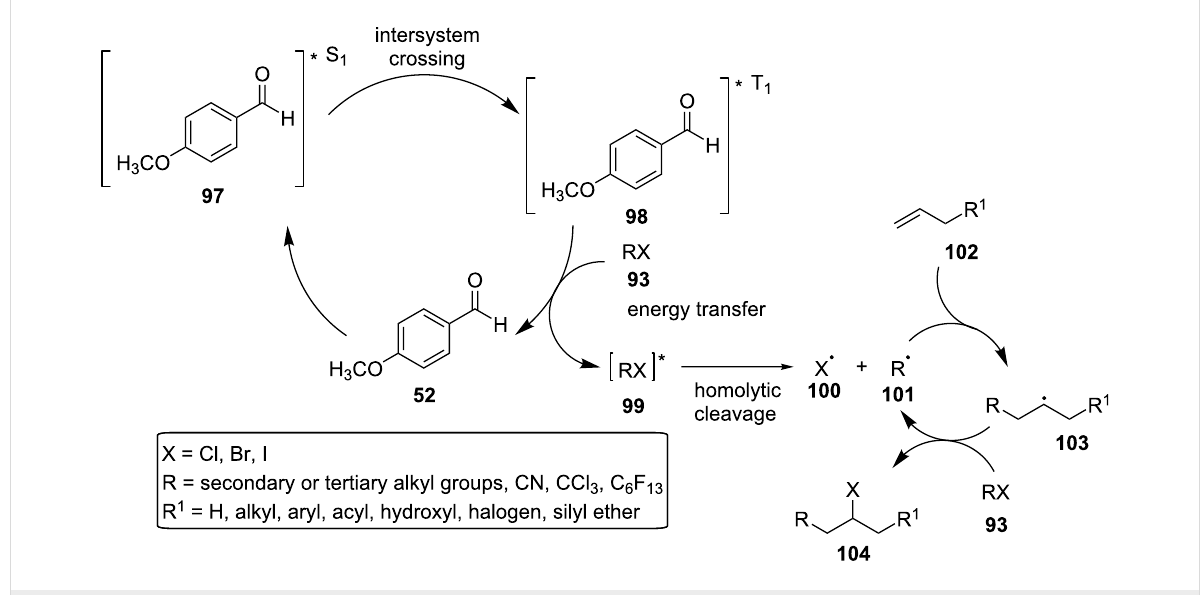
Scheme 25: Proposed triplet sensitization mechanism of the ATRA reaction in the presence of 4-anisaldehyde ( 52